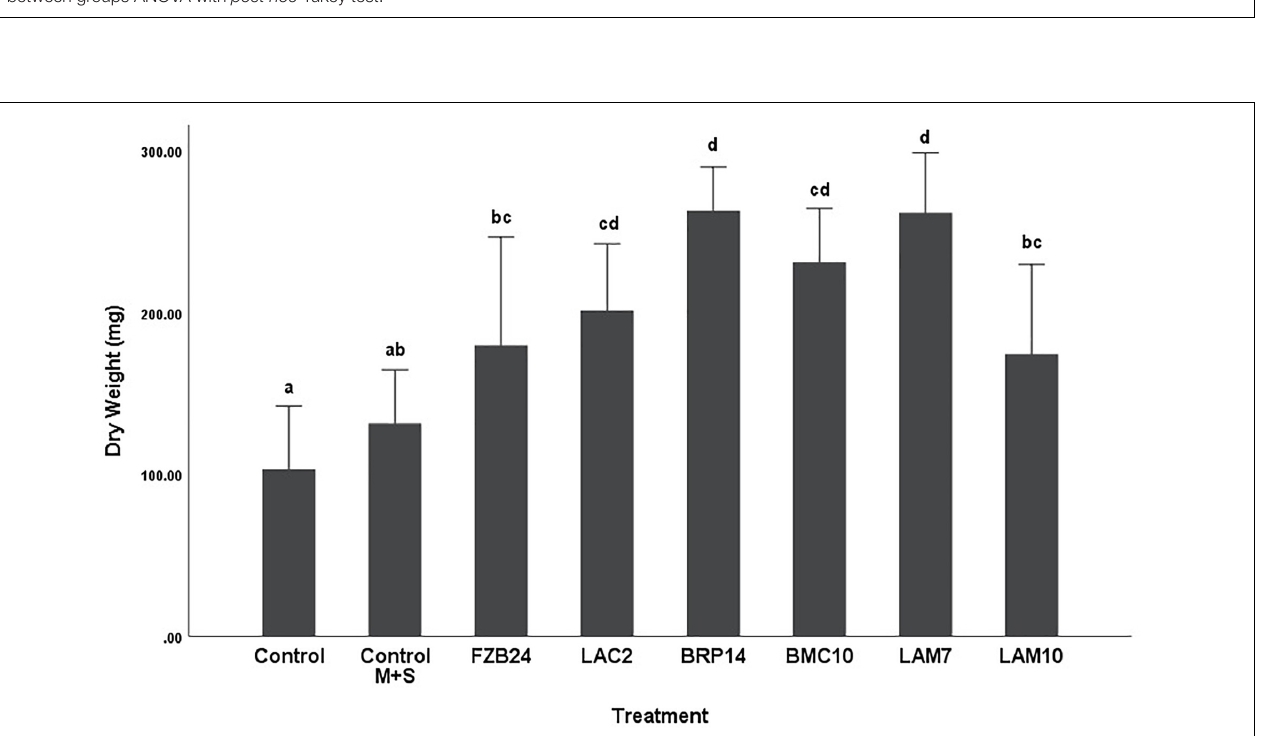
FIGURE 2 | Growth response of plants exposed to BVCs from isolates growing on solid MR-VP media. Dry weight of plants is measured in (mg), error bars represent confidence interval of the mean 99% ( n = 8). Isolates which share a common letter are not significantly different to one another ( p > 0.01) according to one-way between groups ANOVA with post hoc Tukey test.